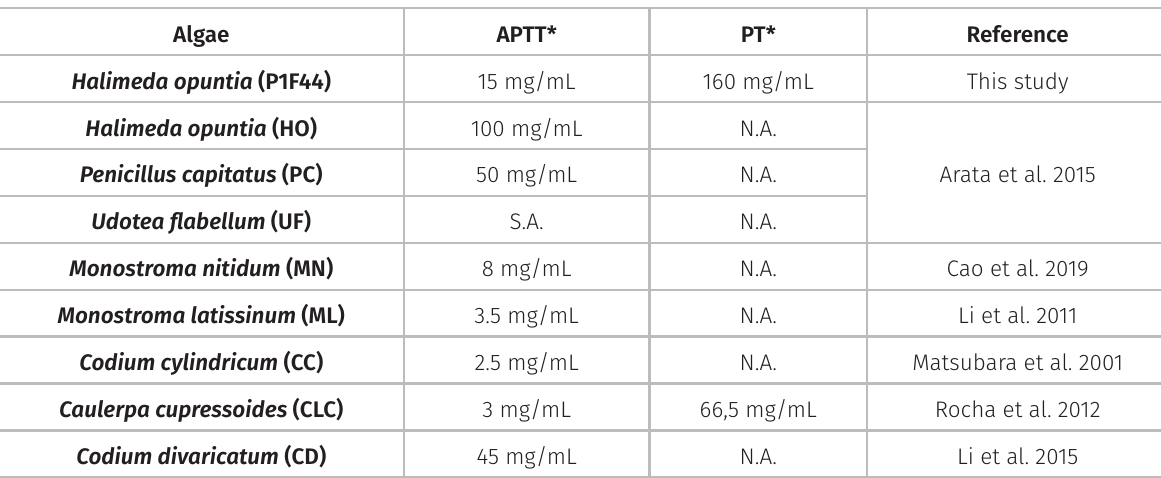
Figure 4. Anticoagulant activity revealed by the APTT (4a) and PT (4b) assays for the purified SP fraction (P1F44) from H. opuntia compared to the fractions obtained by Arata et al. (2015) (HO, PC, UF) and other authors. Caption: UFH – Unfractionated Heparin; HO – Halimeda opuntia ; PC – Penicillus capitatus ; UF – Udotea flabellum; MN – Monostroma nitidum ; ML – Monostroma latissinum ; CC – Codium cylindricum ; CLC – Caulerpa cupressoides ; CD – Codium divaricatum . Table I. Comparison between the activities of different SP in the APTT and PT